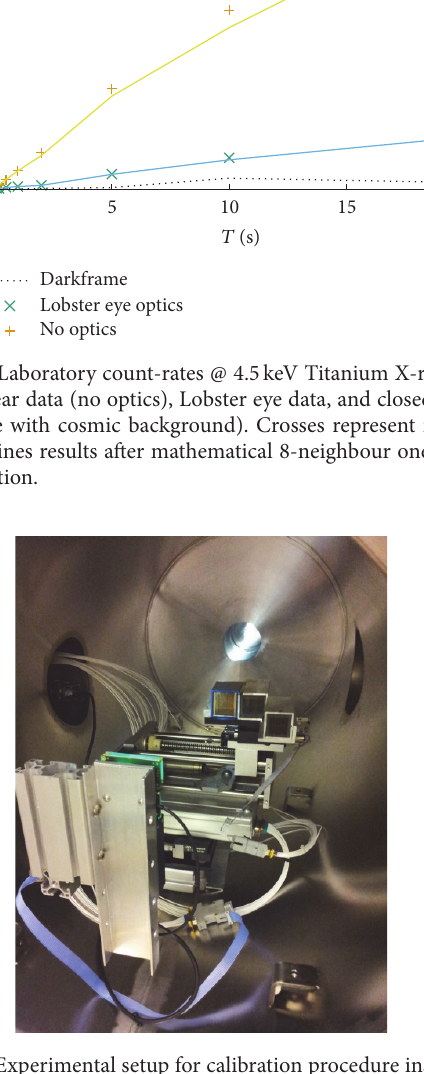
Figure 5: Experimental setup for calibration procedure inside vac- uum chamber of X-ray optics (University of Colorado at Boulder): image taken from [1].